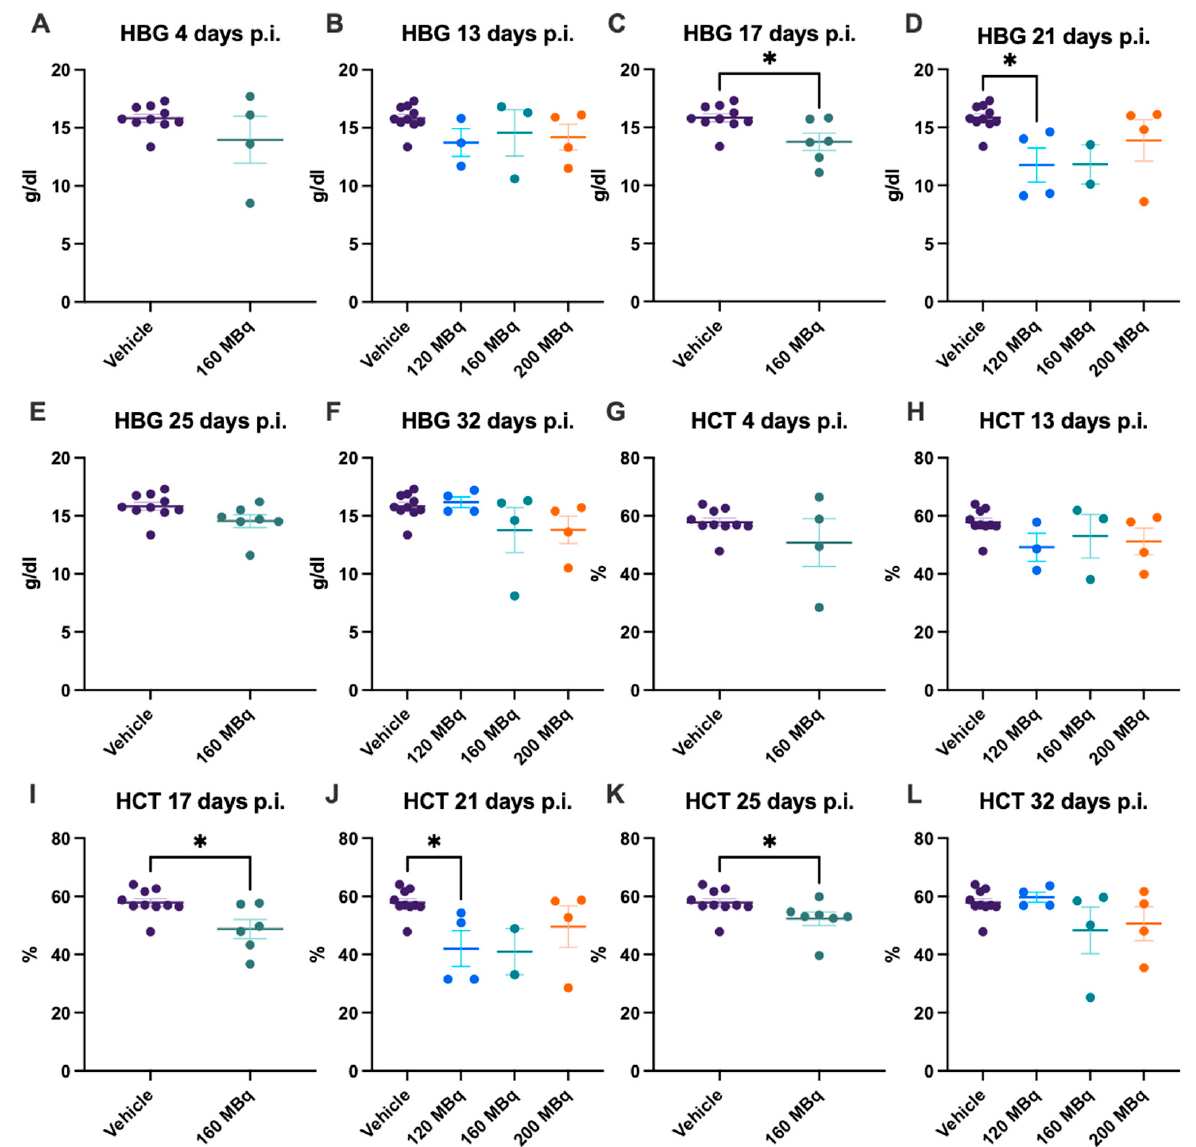
Figure 4. HBG after 4 ( A ), 13 ( B ), 17 ( C ), 21 ( D ), 25 ( E ), and 32 days ( F ) post injection of 120 MBq ( B , D , F ), 160 MBq ( A – F ), or 200 MBq ( B , D , F ). HCT after 4 ( G ), 13 ( H ), 17 ( I ), 21 ( J ), 25 ( K ), and 32 days ( L ) post injection of 120 MBq ( H , J , L ), 160 MBq ( G – L ), or 200 MBq ( H , J , L ). Values are presented as individual plots with group mean ± SEM. Differences between groups were analyzed